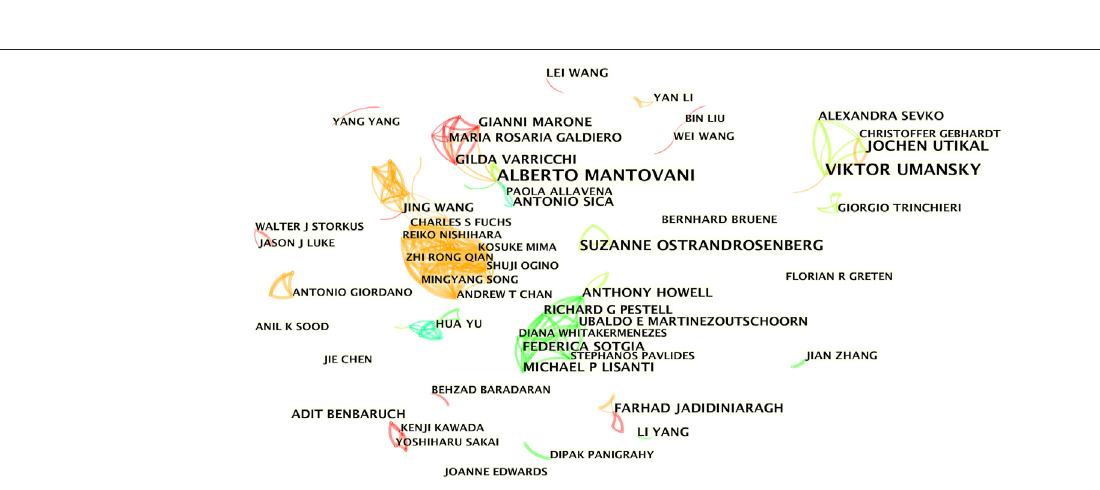
Frontiers in Pharmacology |